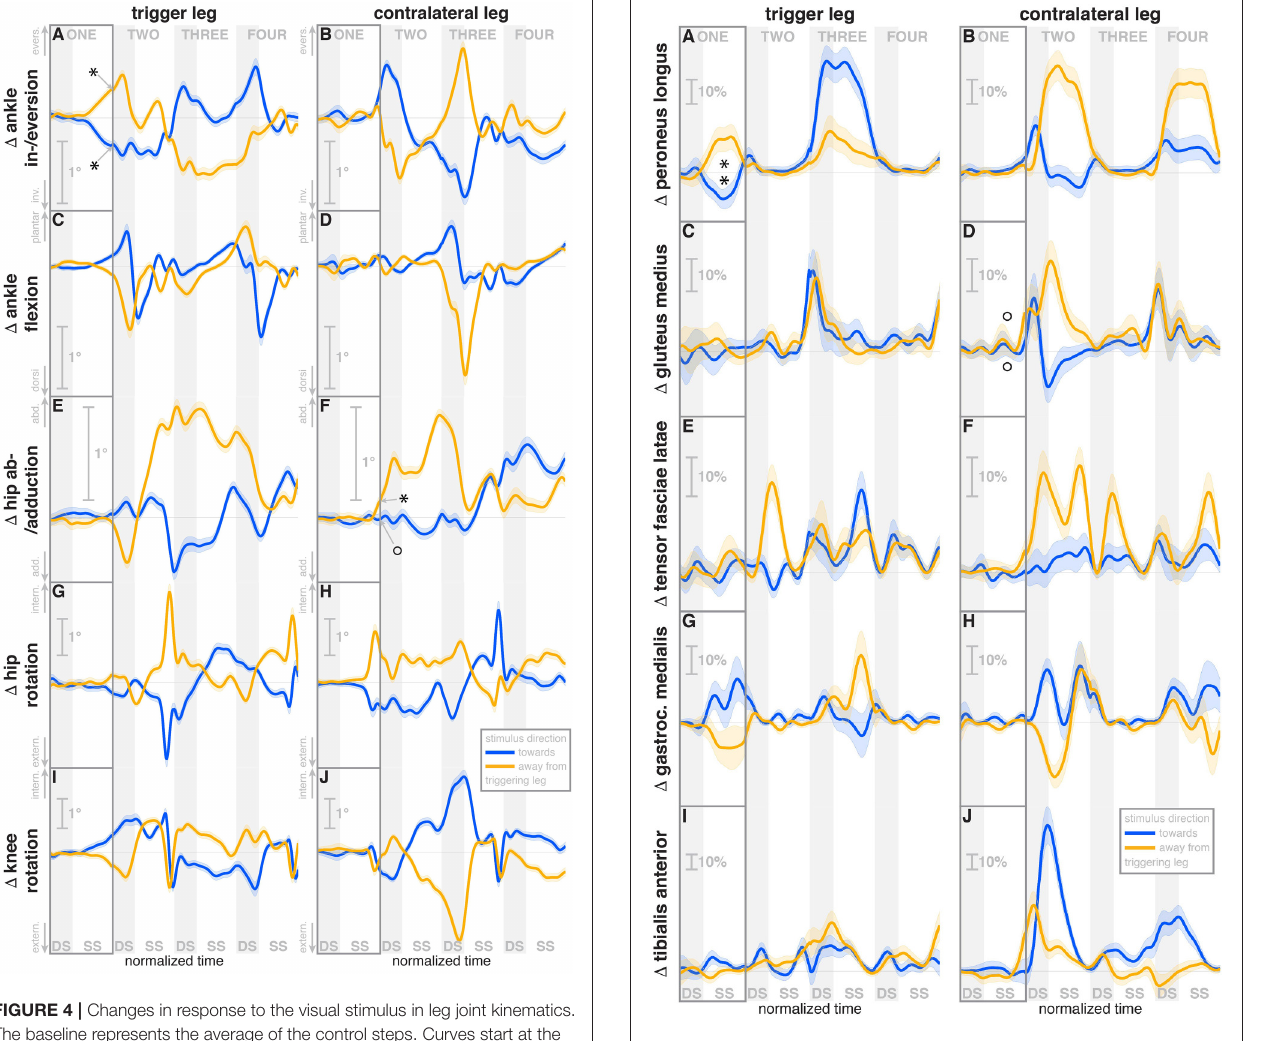
FIGURE 5 | Changes in response to the visual stimulus in leg muscle EMG. The baseline represents the average of the control steps. Curves start at the heelstrike triggering the stimulus and show the subsequent four steps in normalized time, with the first step marked for clarity. Blue curves correspond to fall stimuli toward the triggering leg, orange curves to fall stimuli away from the triggering leg. Asterisks indicate statistically significant difference from zero, circles indicate lack of statistically significant difference from zero (see Table 3 ). Lack of marks indicate that no hypothesis was statistically tested. The shaded areas are 95% confidence intervals calculated using simplifying assumptions (see Methods). Data are normalized by rescaling to the grand average over the control steps for each subject as 100%, then subtracting the average over the control steps at each time point (see